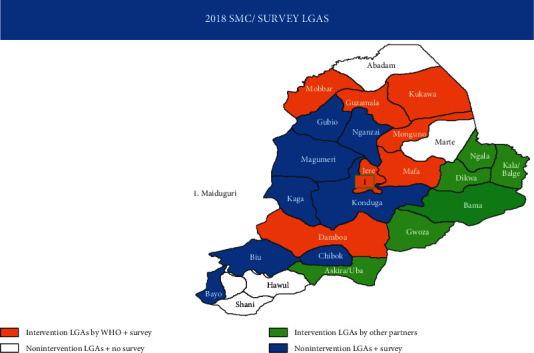
Map showing the 27 Local Government Areas of Borno State.